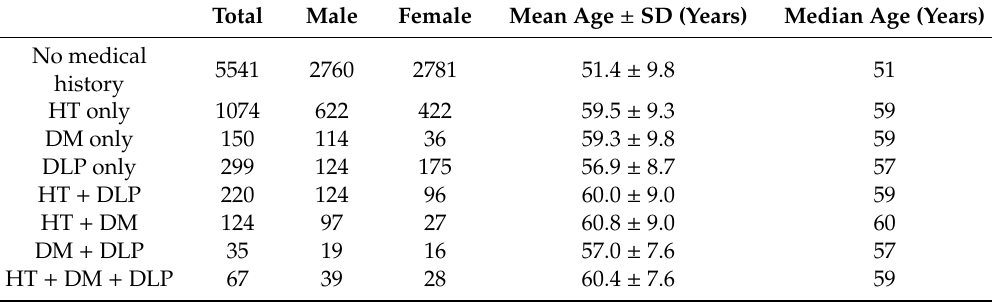
Table 1. Number and age distribution of participants without and with hypertension (HT), diabetes mellitus (DM), and / or dyslipidemia (DLP).